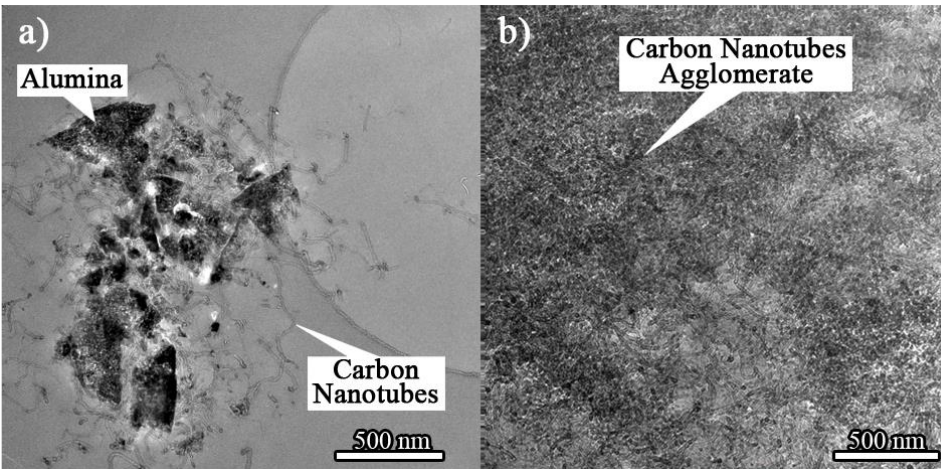
Figure 4. HRTEM image of ( a ) HYB composite; ( b ) PHY composite.